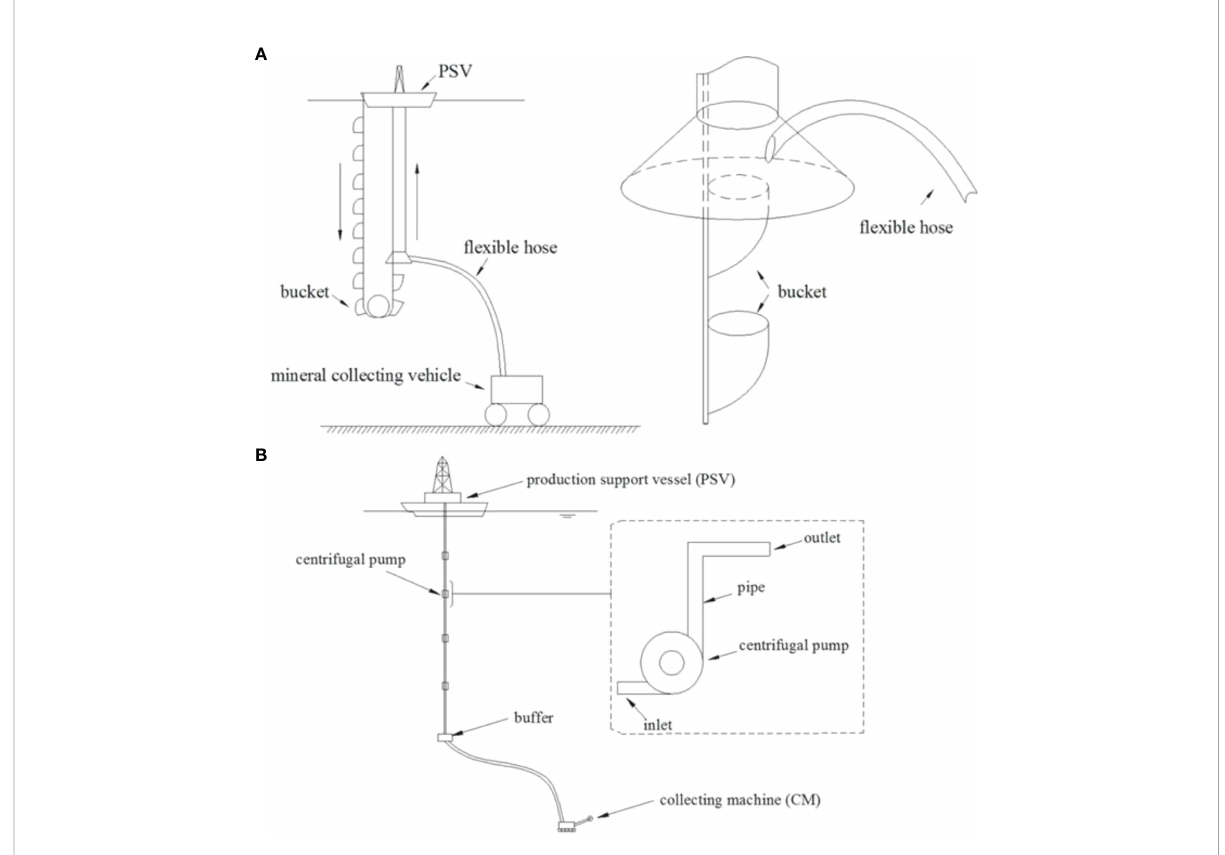
FIGURE 3 Schematic diagrams of a CLB (A) and HL (B)